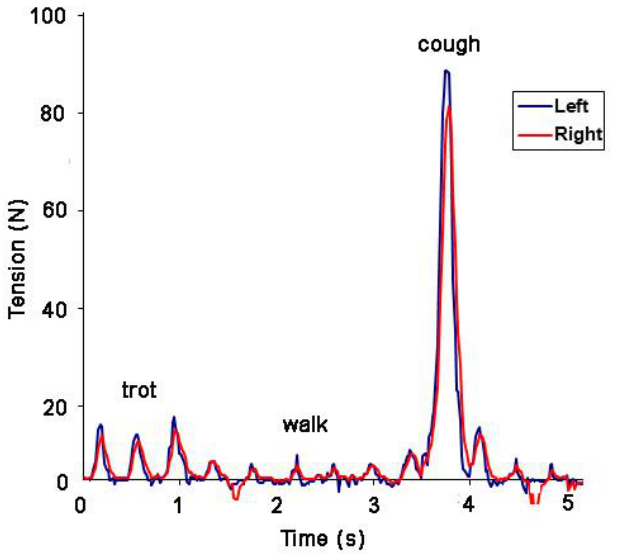
Figure 9. Rein tension data for a horse that coughed during data collection at walk.